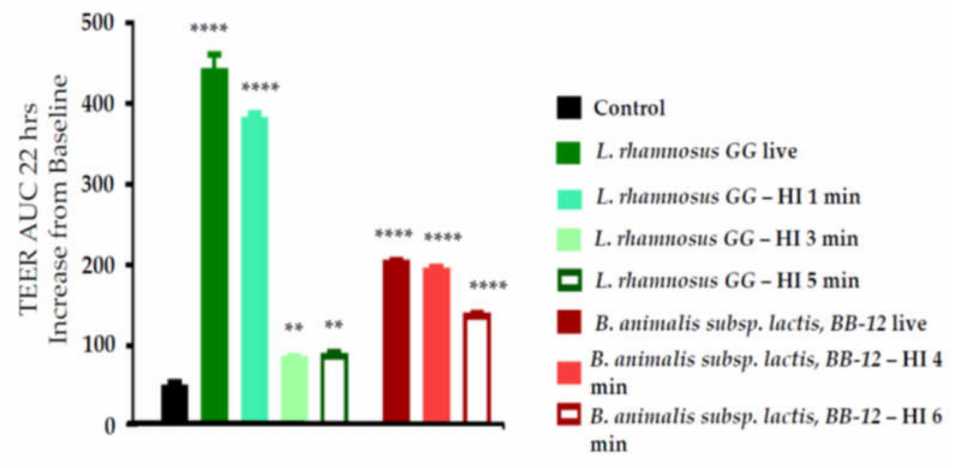
Figure 1. Transepithelial electrical resistance (TEER) area under curve (AUC) change after treatment of Caco-2 cells on the apical side with live or heat-inactivated (HI) L. rhamnosus GG or B. animalis subsp. lactis, BB-12 for 22 h. Data are mean + SD ( n = 3). One-way ANOVA p value < 0.0001. ** p < 0.01; **** p < 0.0001 vs.